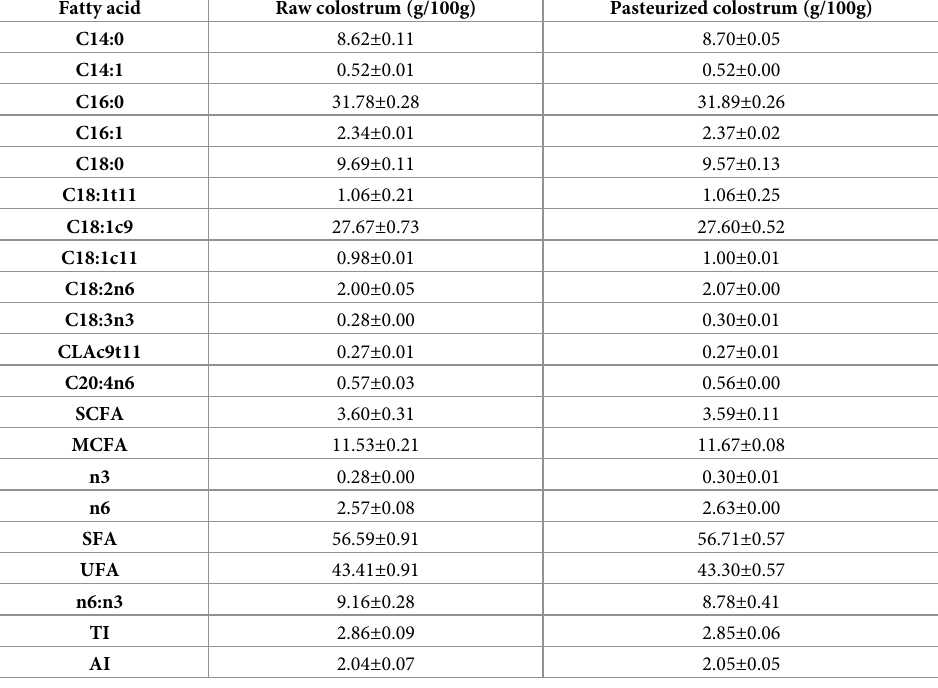
UFAs represented around 43 g/100 g in bovine colostrum, which is a higher value than that found by [4] (28.29 g/100 g) and by [55] (less than 40 g/100 g). Of these, about 27 g/100 g was oleic acid (C18:0c9), also constituting a higher value than that found by [4] (17.38 g/100 g). Table 5. Fatty acids profile of raw and pasteurized colostrum.